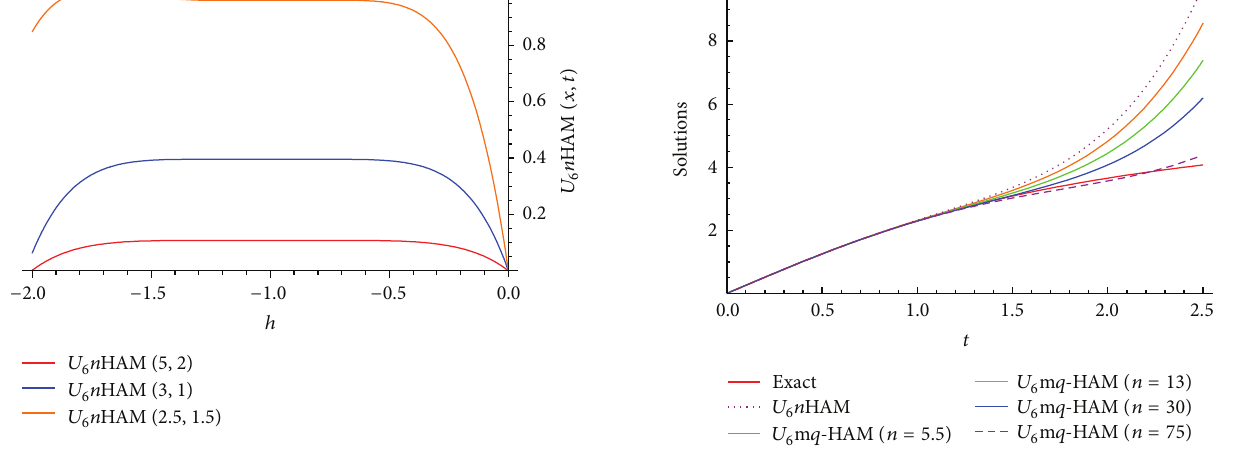
Figure 1: ℎ -curve for the 𝑛 HAM (m 𝑞 -HAM; 𝑛 = 1) approximation solution 𝑈 6 (𝑥,𝑡) of problem (28) at different values of 𝑥 and 𝑡 .